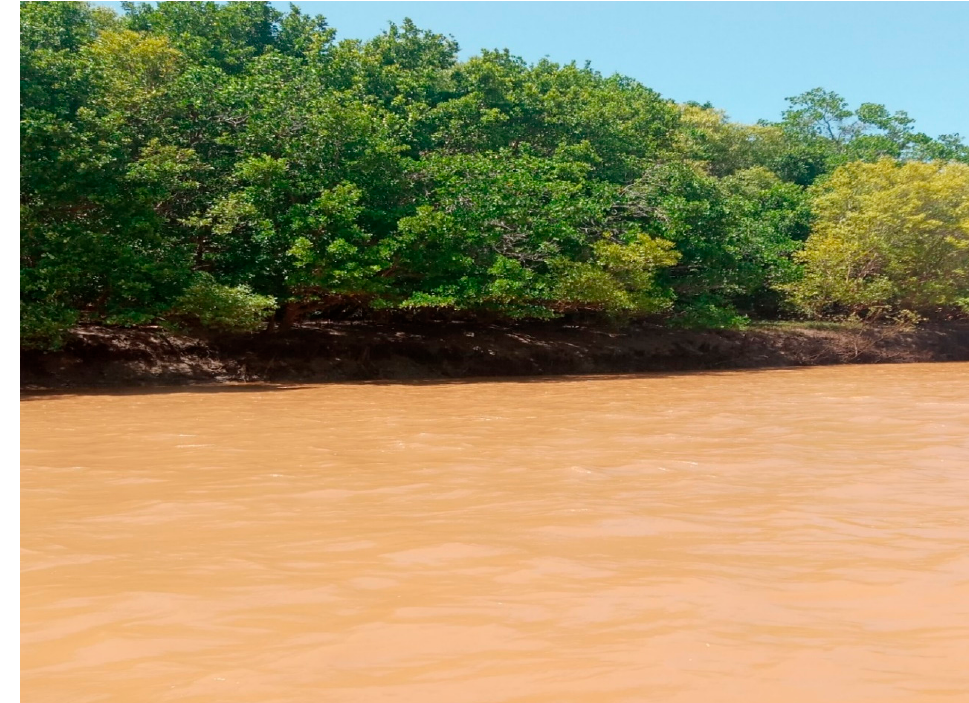
Figure A2. The lower section of the Ruvu sub-basin (with built-up activities some metres from the vicinity of the river).